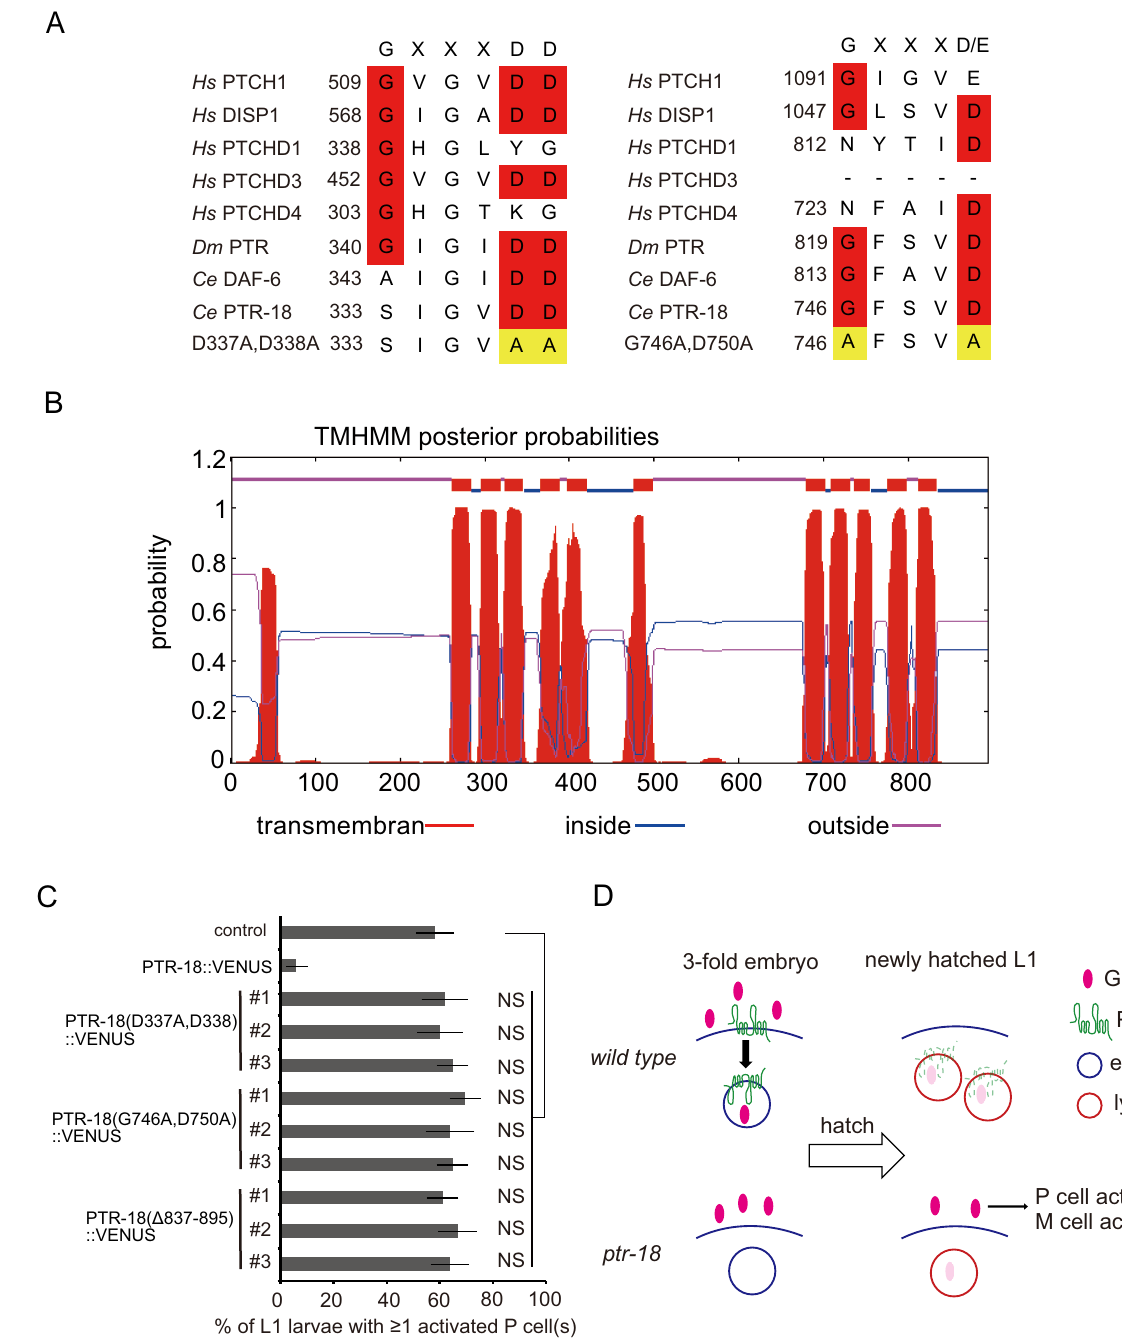
Fig 8. The GXXXDD and GXXXD/E motifs and C-terminal cytoplasmic region of PTR-18 protein are required for appropriate function. (A) Comparison of GXXXDD and GXXXD/E motifs. The amino acid substitutions introduced in PTR-18(D337A, D338A)::VENUS and PTR-18 (G746A, D750A)::VENUS are shown in the bottom panel. (B) Membrane topology of PTR-18 predicted by the TMHMM algorithm. Note that the C- terminal portion of PTR-18 is predicted to be cytoplasmic. (C) Effects of mutated PTR-18::VENUS on the defects of ptr-18 mutant animals